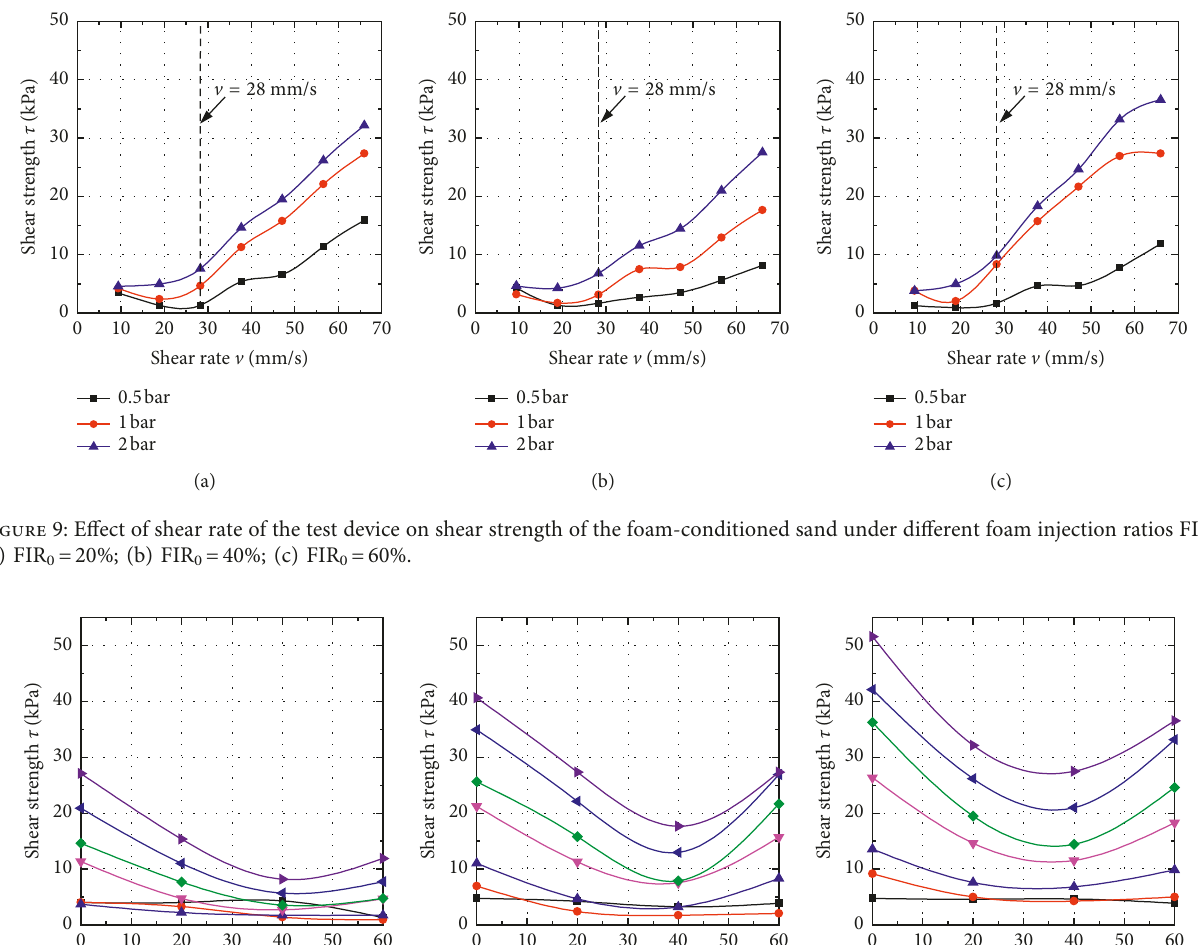
Figure 10: Effect of initial foam injection ratio FIR 0 on the shear strength of the foam-conditioned sand at different vertical soil stresses: (a) 0.5 bar; (b) 1 bar; (c) 2bar.